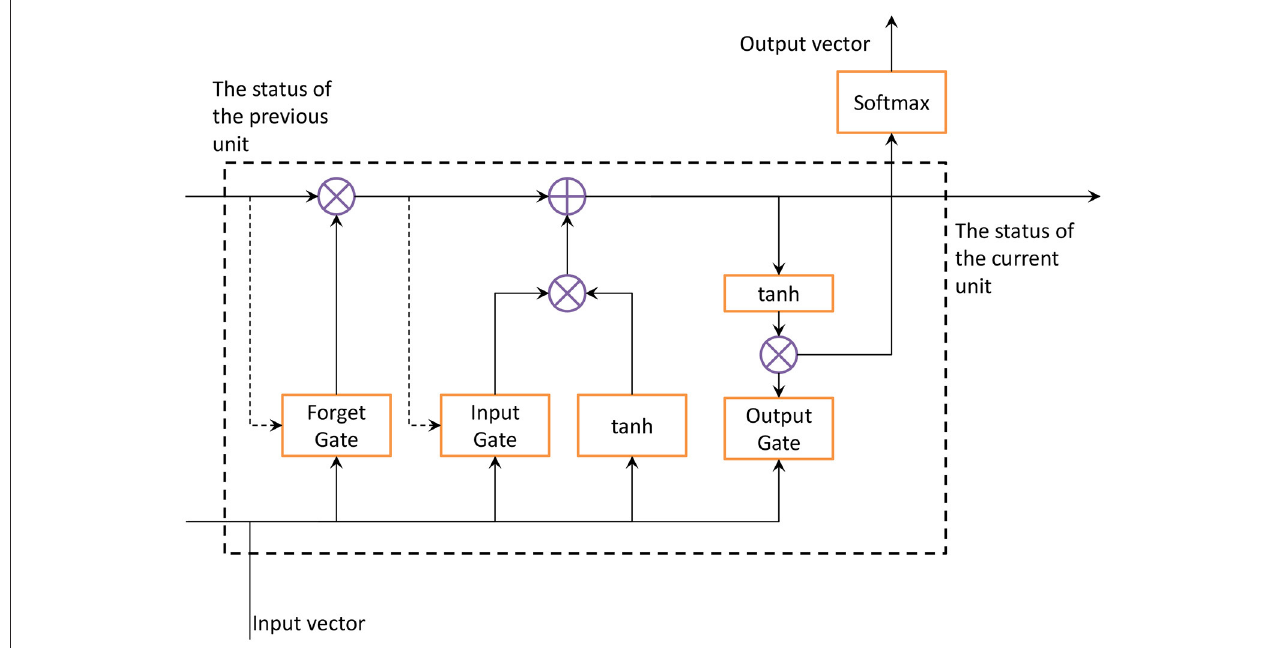
FIGURE 5 | ILSTM structure diagram.